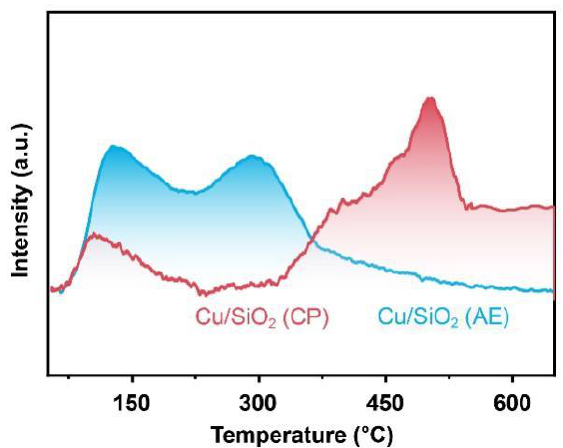
Figure 5. ( a ) XPS spectra of the Cu/SiO 2 catalysts; ( b ) Cu LMM Auger spectra of the Cu/SiO 2 catalysts.